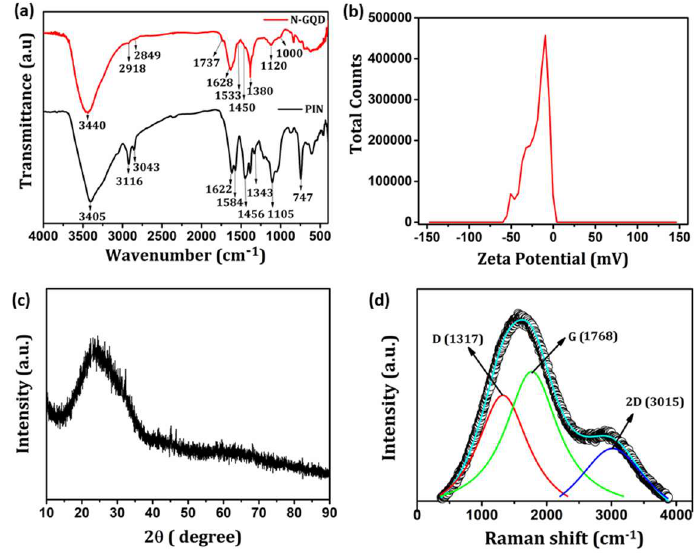
Figure 2. ( a ) FTIR spectra of PIN and N-GQDs, ( b ) zeta potential, ( c ) X-ray diffraction patterns, and ( d ) Raman spectrum of as-synthesized N-GQDs.